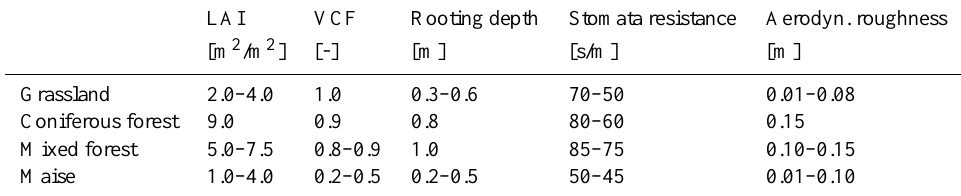
Table 1. Plant parameters used for modeling in WaSiM-ETH.